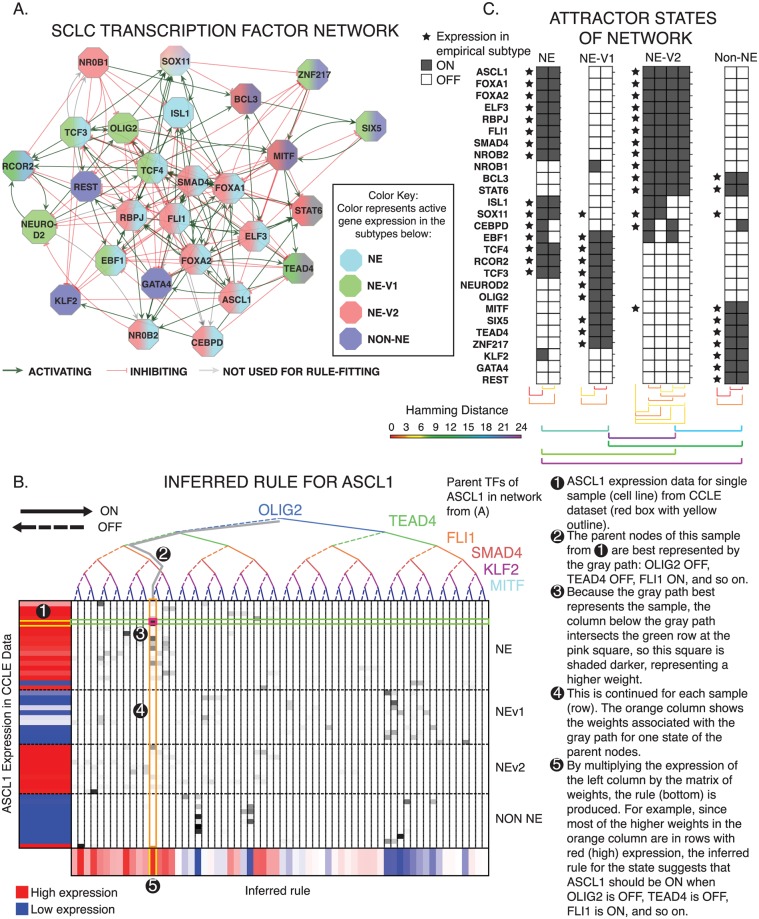
TF network simulations reproduce subtypes as attractors.A. Regulatory network of differentially expressed TFs from each of the 11 co-expressed gene modules in Fig 2B. Colors indicate which phenotype each TF is upregulated in. Red edges indicate inhibition (on average), and green activation (on average). B. Probabilistic Boolean rule fits for ASCL1. The target gene is a function of all the genes along the binary tree at the top, while expression of the target is shown on the left. Each row represents one cell line, each column represents one possible input state, and the bottom shows the inferred function F for every possible input state. Color ranges from 0 = blue (highly confident the TF is off), to 0.5 = white, to 1 = red (highly confident the TF is on). Rows are organized by subtype (top to bottom: NE, NEv1, NEv2, non-NE). C. Attractors found with asynchronous updates of Boolean network. 10 attractors were found, and each correlates highly with one of the four defined subtypes (represented by stars). Hamming distance between intra-subtype attractors and inter-subtype attractors are shown. The average distance between intra-subtype attractors was around 2.5, while the average distance between subtype attractors was around 16, signifying that the variation between subtypes is much greater that that within a single subtype. Specifics of the probabilistic simulation are described in Results.